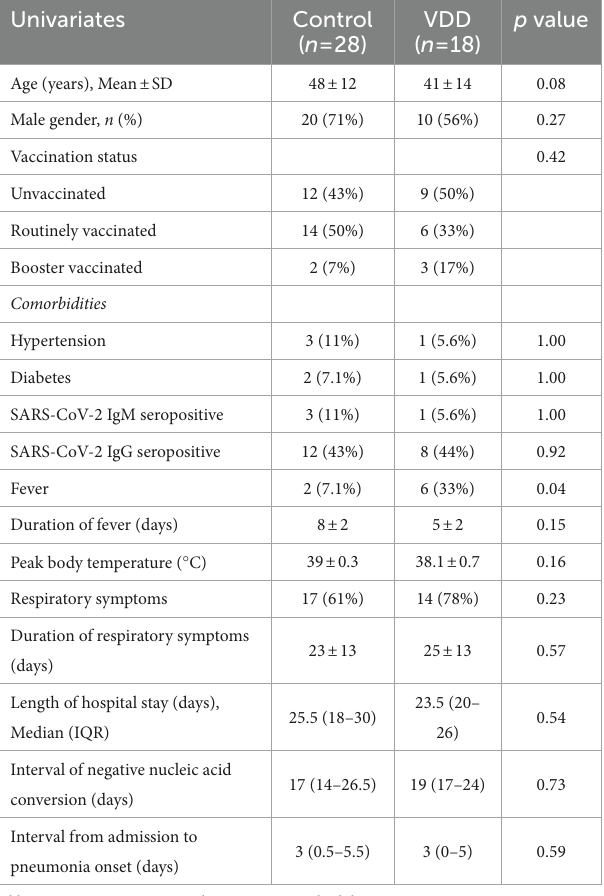
TABLE 3 Demographic and clinical characteristics of patients with pneumonia induced by the Delta